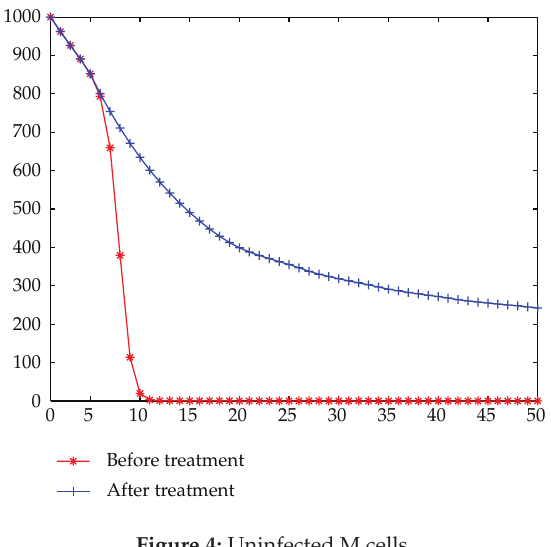
Figure 4: Uninfected M cells.